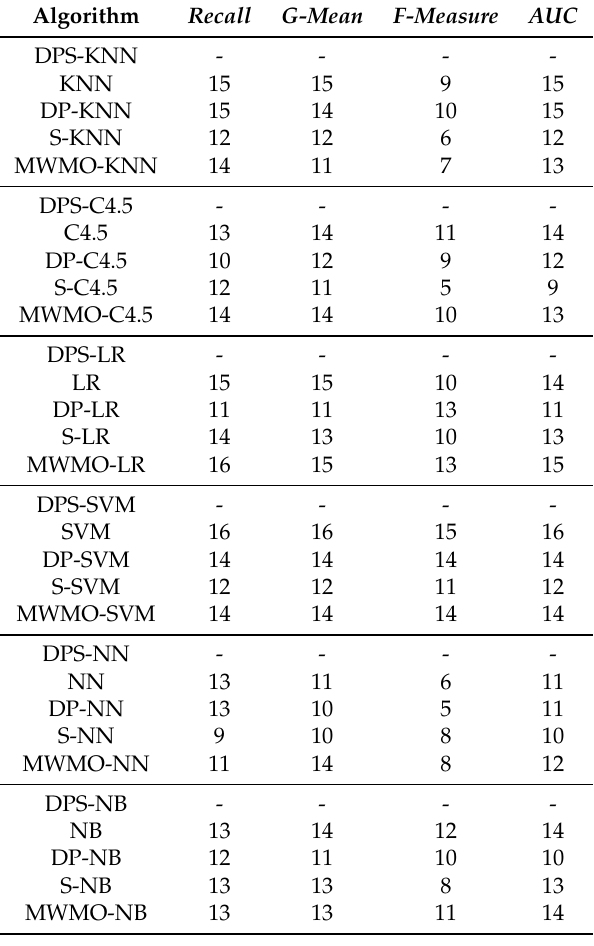
Table 7. Number of data sets on which DPS methods outperform the compared